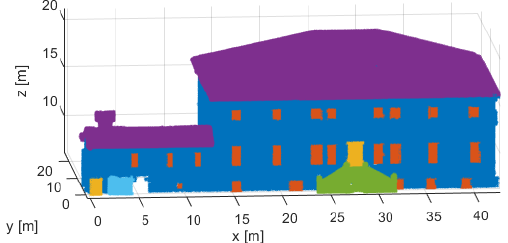
Figure 2. Reference segmentation of Villa Roberti